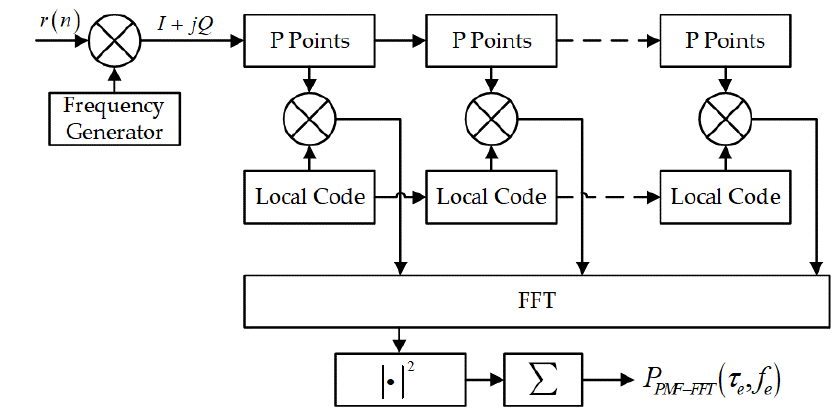
Figure 3. Structure of match filter method.